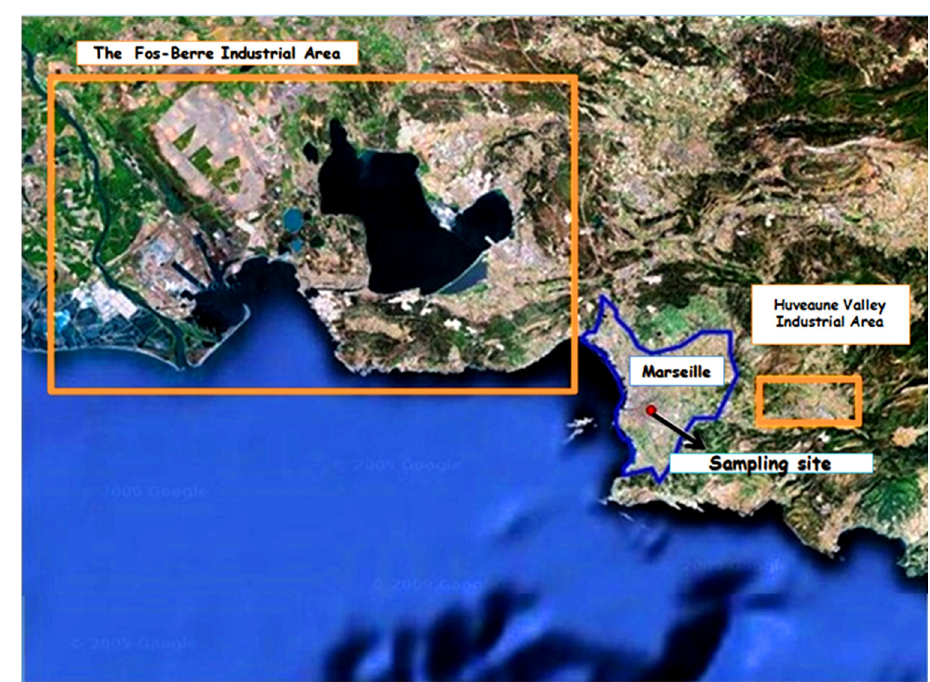
Figure 1. Location map of the study area. The industrial areas surrounding Marseille are also